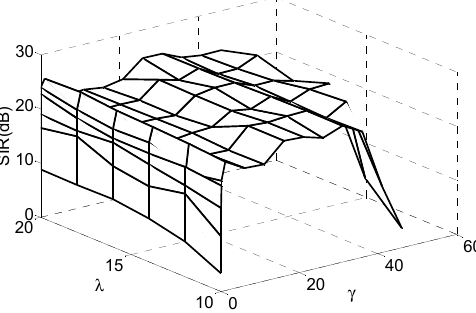
Figure 4. SIRs versus varying thresh γ and varying Lagrange parameter λ .